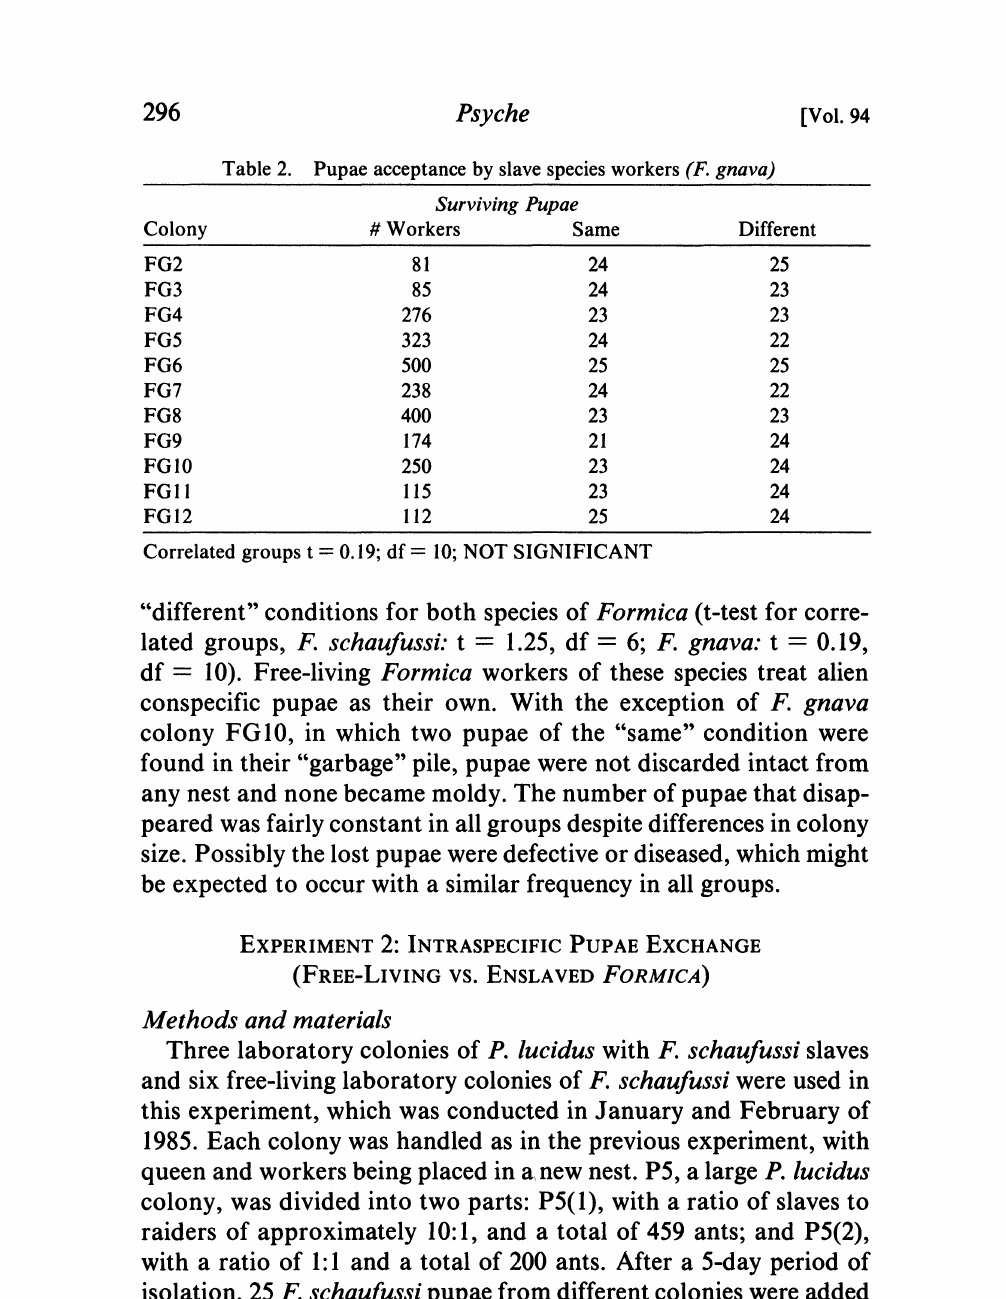
Table 2. Pupae acceptance by slave species workers (F. gnava)